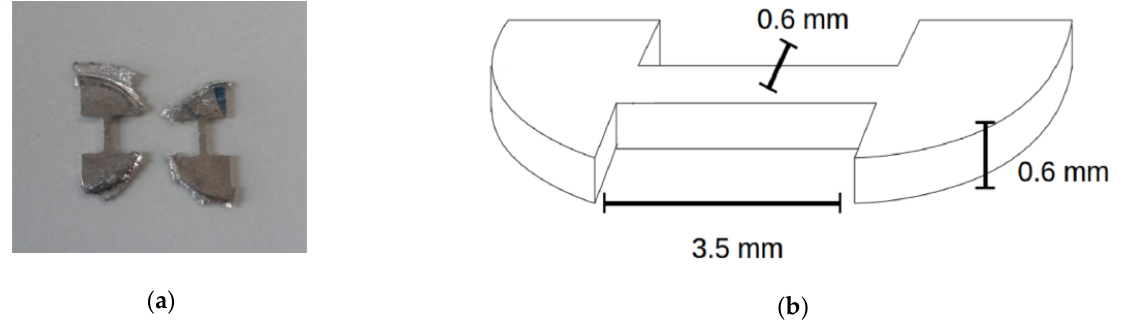
Figure 1. ( a ) Tensile test samples cut from Mg alloys in question, ( b ) dimensions of a cut sample [15].